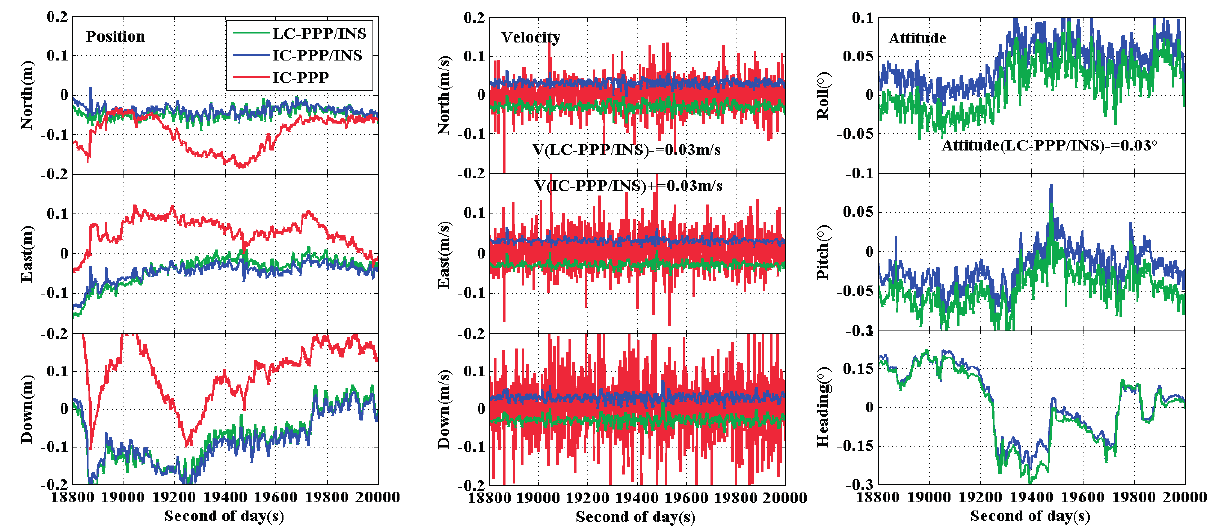
Figure 9. Differences of positions, velocities and attitudes of IC-PPP ( red line), LC-PPP/INS ( green line) and IC-PPP/INS ( blue line) with respect to the reference solutions; LC-PPP/INS and IC-PPP/INS velocities are shifted by − 0.03 m/s and +0.03 m/s, and the LC-PPP/INS attitudes are shifted by − 0.03° for